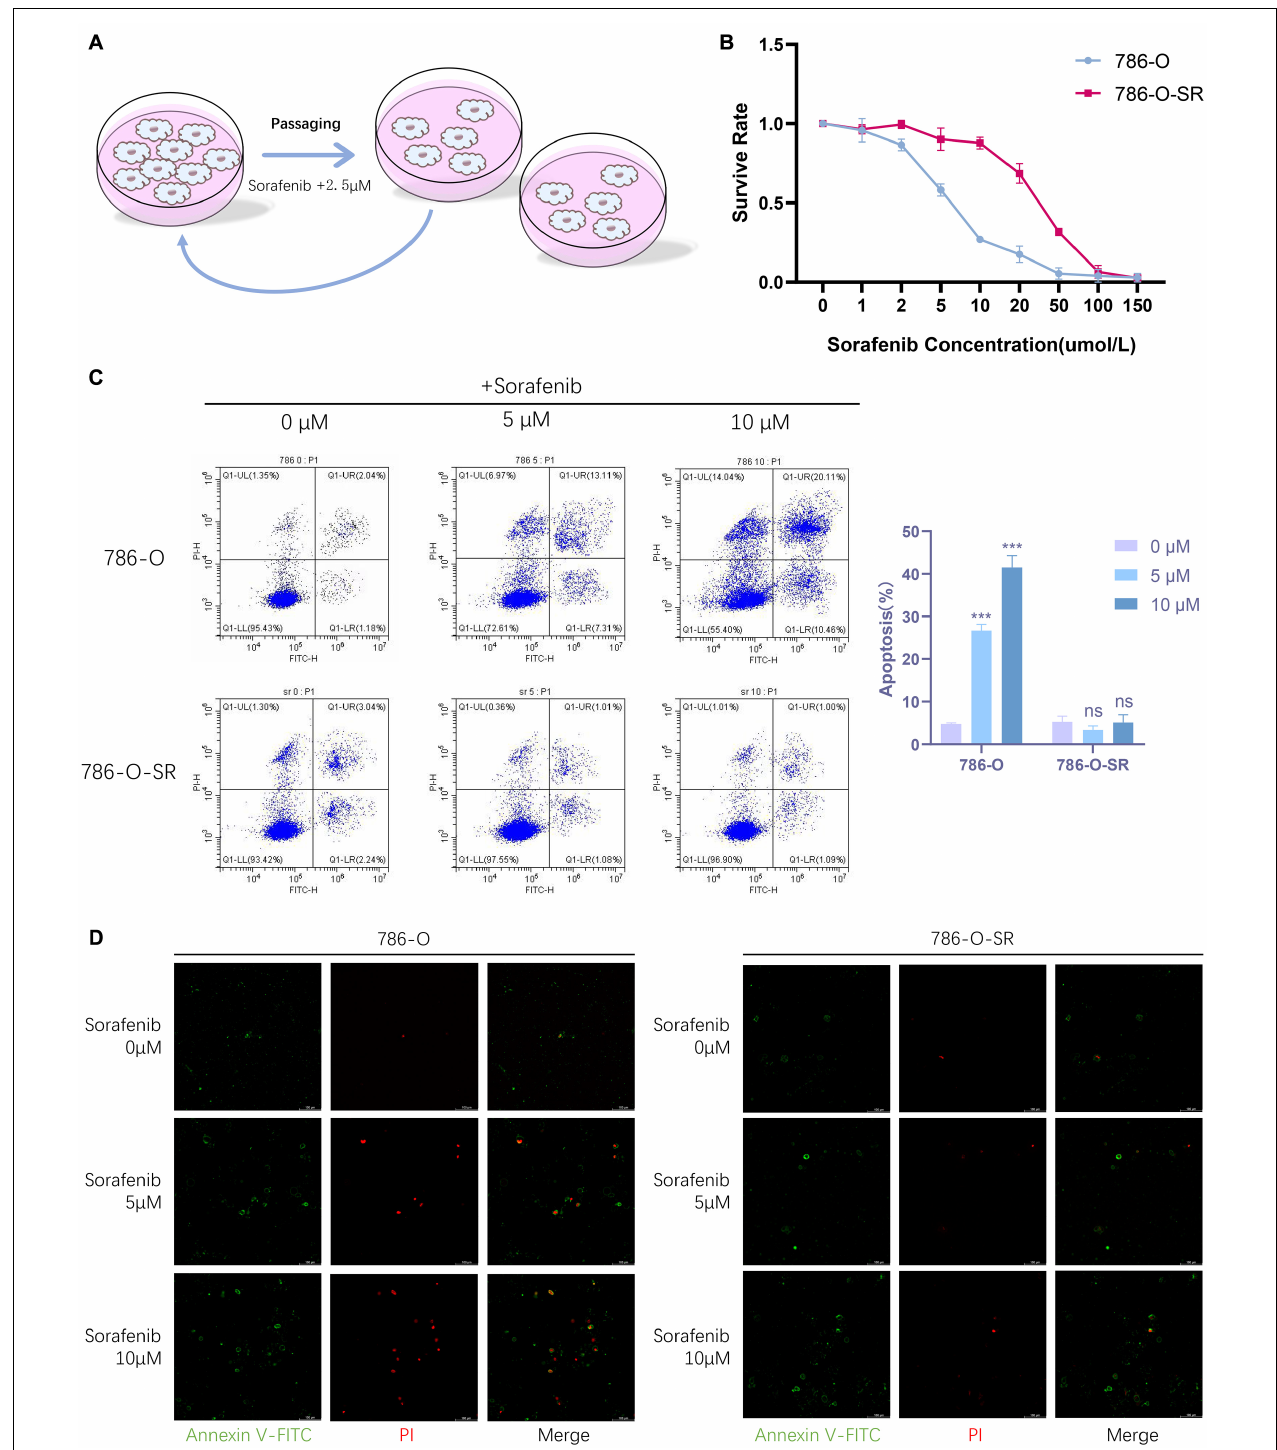
FIGURE 1 | Renal clear cell carcinoma TKI resistant cell strain 786-O-SR is resistant to sorafenib. (A) Induction process of TKI-resistant cell line 786-O-SR. (B) CCK8 assay of cell viability of 786-O and 786-O-SR at different sorafenib concentrations. (C) Flow cytometry assay of apoptosis of 786-O and 786-O-SR in response to different sorafenib concentrations (detected by annexin-V combined with PI). (D) Apoptosis situations of 786-O and 786-O-SR at different sorafenib concentrations observed by fluorescence microscopy. Mean ± SEM are provided ( n = 3). *** P < 0.001; ns, not significant according to two-tailed Student’s t -test.